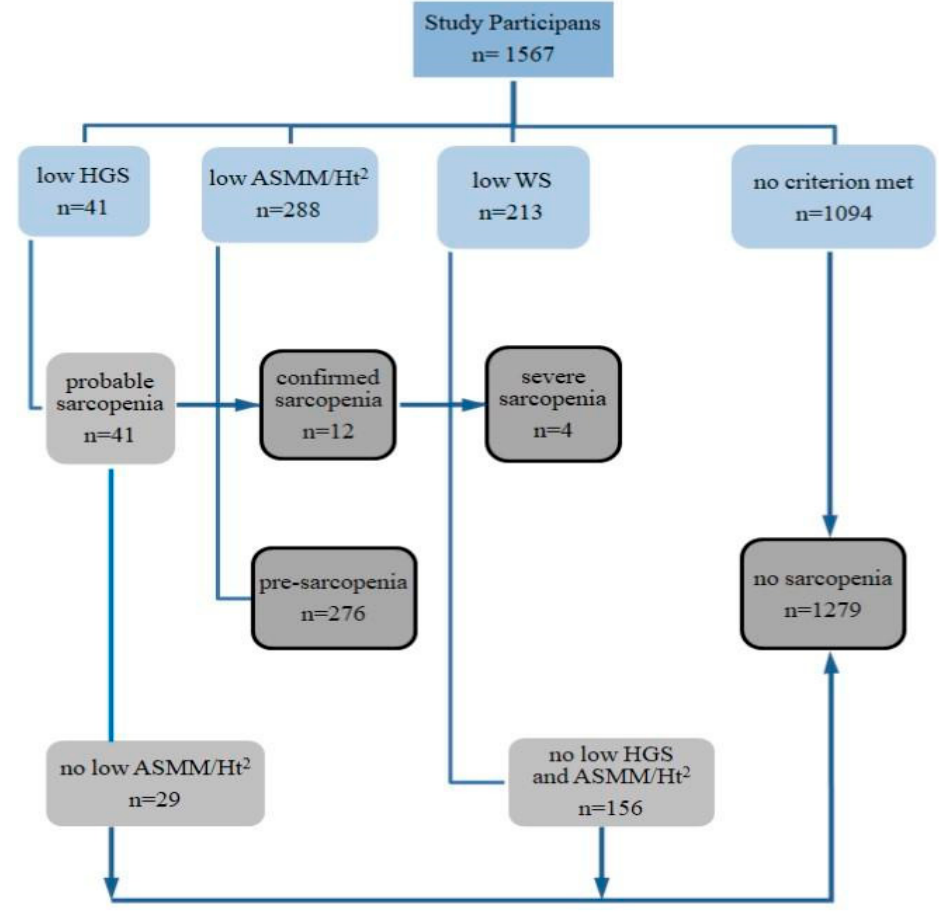
Figure 1. Scheme of identification and assessment of sarcopenia in participants of the study. HGS—hand grip strength, ASMM—appendicular skeletal muscle mass, Ht—height, WS—walking